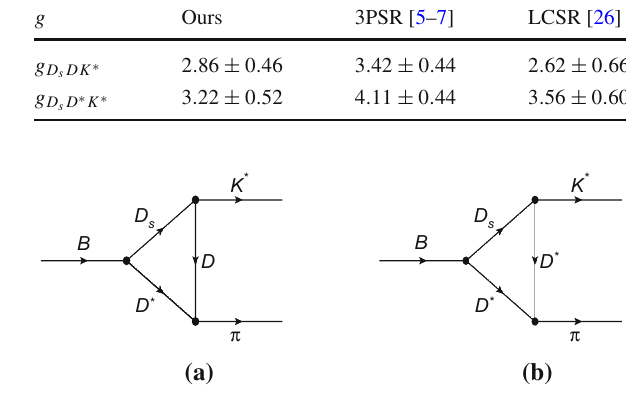
Table 5 Parameters appearing in the fit functions for the g D and g